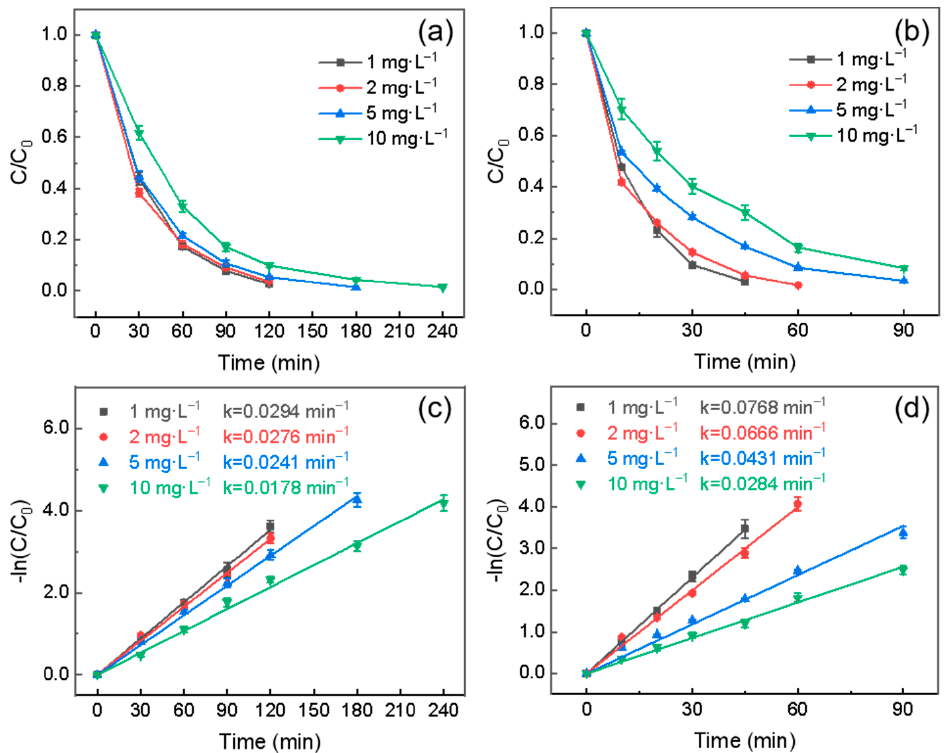
Figure 3. Effect of initial concentration of ( a ) SMX and ( b ) ENR on their photodegradation, and kinetic curves of ( c ) SMX and ( d ) ENR.